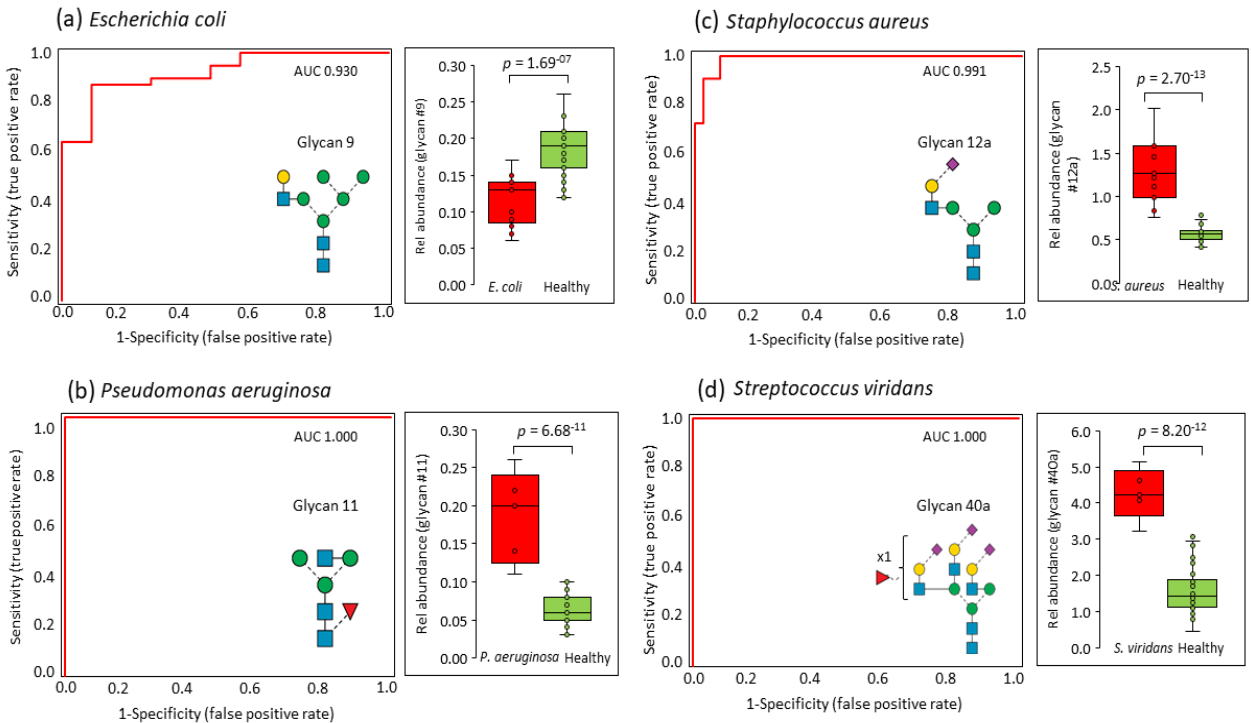
Figure 4. Receiver operating characteristic (ROC) analysis (red trace) of each of the four bacteremic patient groups versus the healthy donor group. Notably, a single N -glycan isomer was able to accurately stratify patients from healthy donors i.e., ( a ) glycan 9 for E. coli -infected individuals, ( b ) glycan 11 for P. aeruginosa -infected individuals , ( c ) glycan 12a for S. aureus -infected individuals, and ( d ) glycan 40a for S. viridans -infected individuals. AUCs and p values are shown.